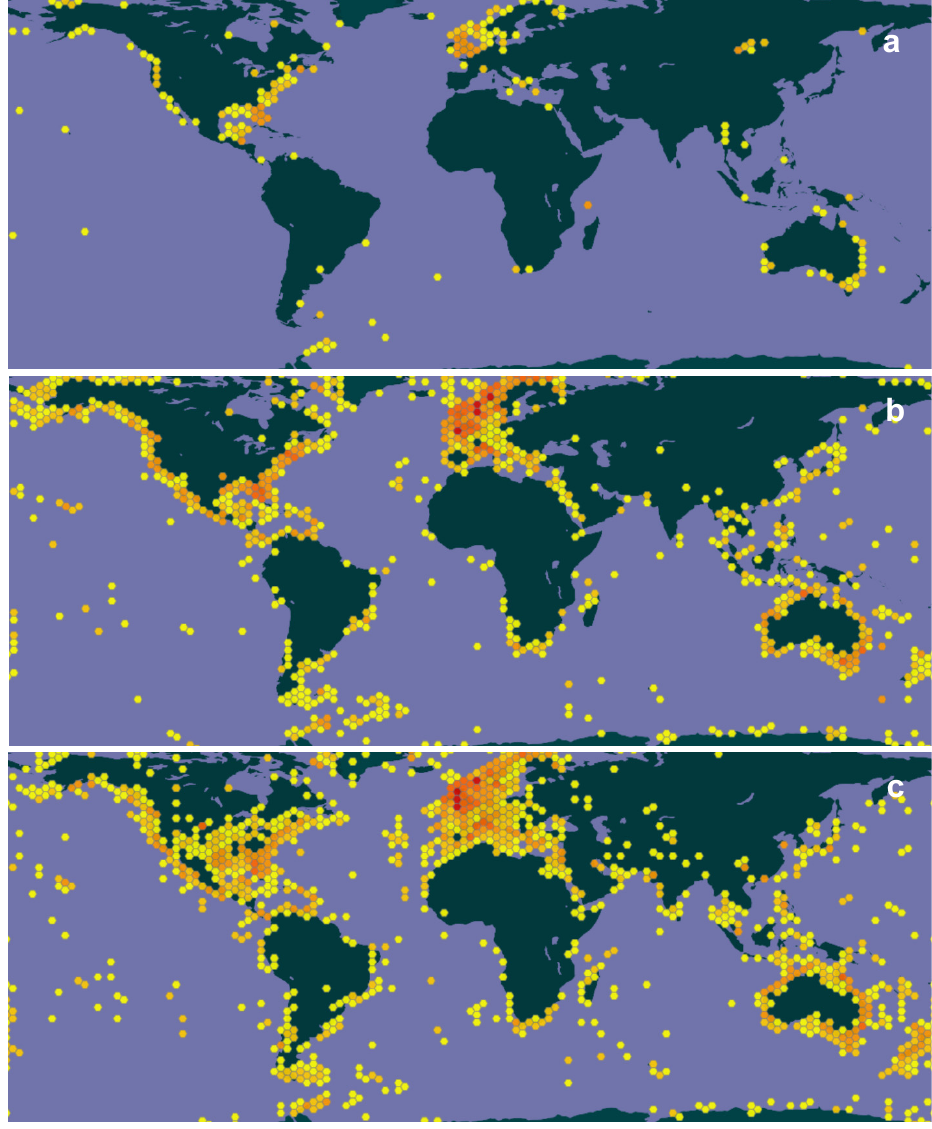
Figure 13. Georeferenced occurrences from GBIF. ( a ) Fabriciidae; ( b ) Sabellidae; ( c ) Serpulidae.